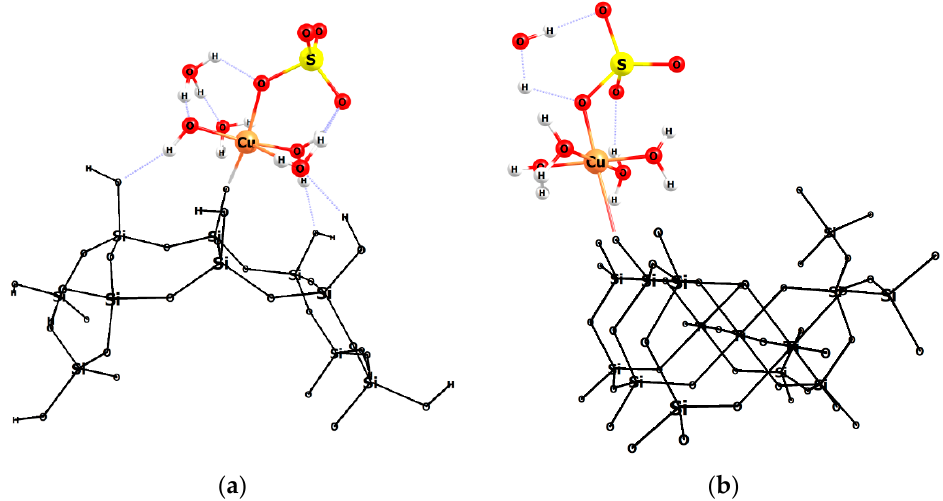
Figure 8. The interaction of the structure CuSO 4 ·5H 2 O with: ( a ) SBA-15, ( b ) ETS-10.